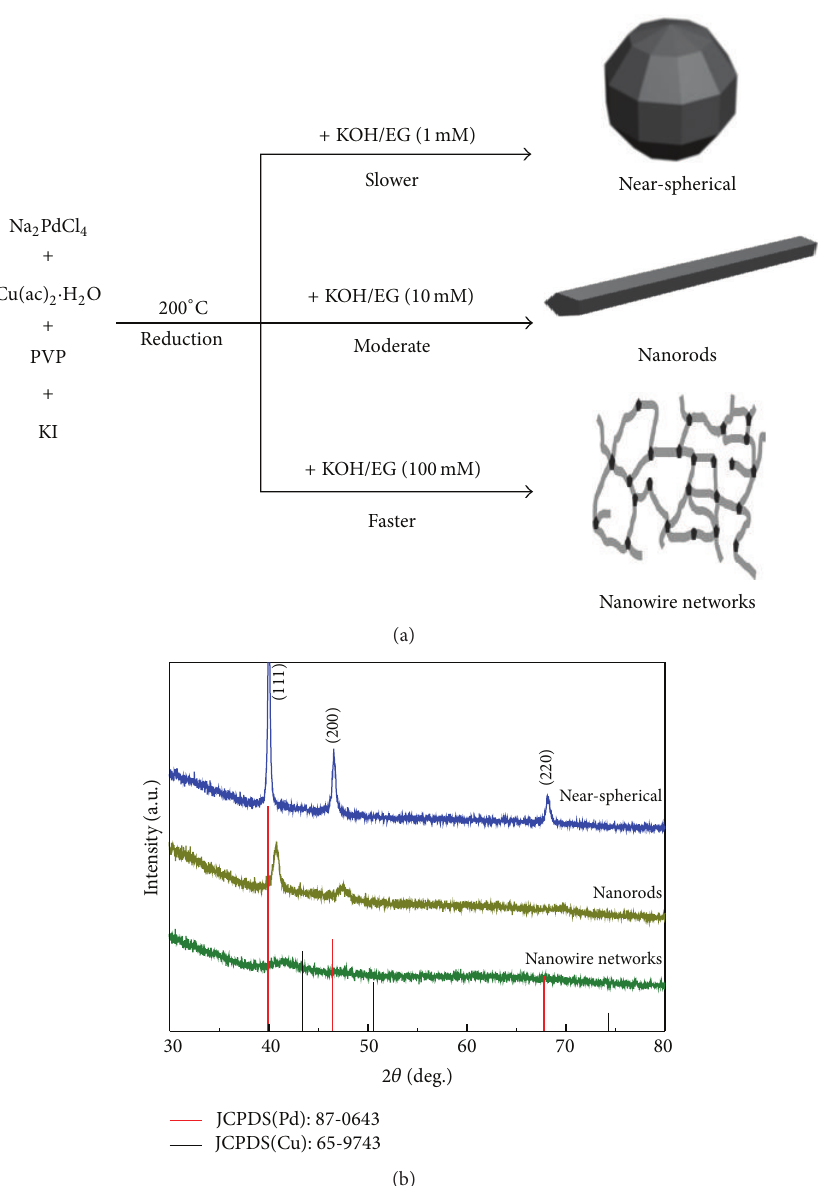
Figure 1: (a) Schematic illustration of the synthetic pathways leading to the formation of Pd-Cu alloys with three different structures and (b) XRD patterns for the corresponding